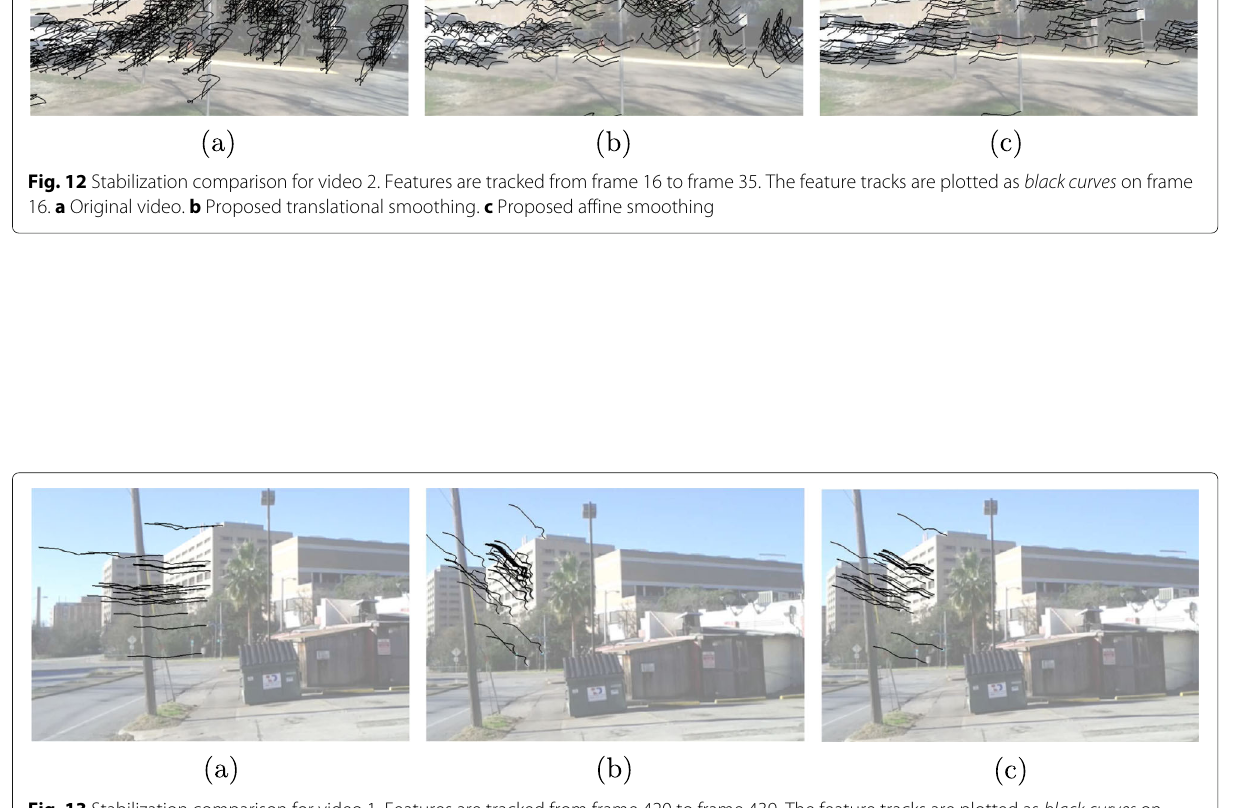
Fig. 13 Stabilization comparison for video 1. Features are tracked from frame 420 to frame 439. The feature tracks are plotted as blackcurves on frame 420. a Constrained KF with small σ p . b Constrained KF with large σ p . c Constrained IMM